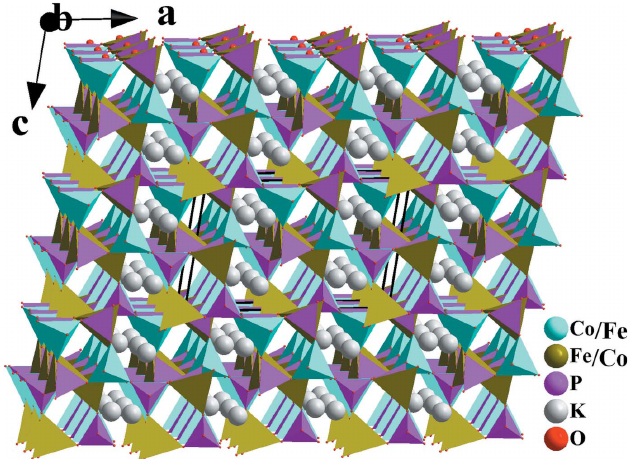
Figure 3 Perspective view of the crystal structure of (cid:2) -KCoFe(PO 4 ) 2 approxi- mately along [010], showing the channels in which the K + cations are